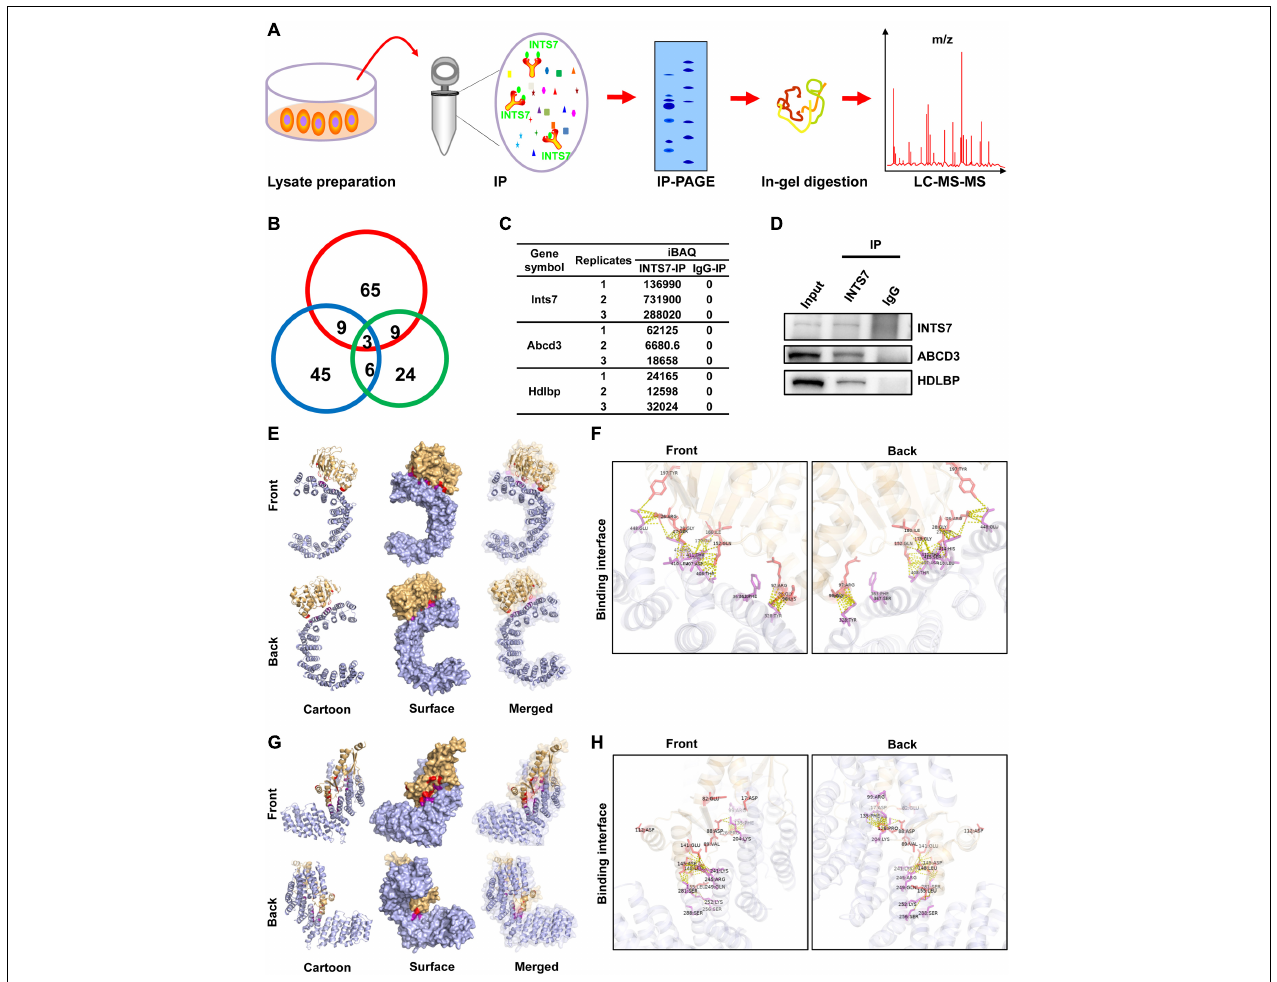
FIGURE 3 | INTS7 interacts with ABCD3 and HDLBP in BM-MSCs. (A) The procedures used to identify INTS7-interacting proteins in BM-MSCs: total endogenous proteins were collected, subjected to INTS7 antibody-based immunoprecipitation, IP-PAGE, in-gel digestion, liquid chromatography separation, and mass spectrometry analysis. (B) Three replicates in (A) were performed, and the quantities of co-occurring proteins were evaluated. (C) The protein expression levels were estimated by the iBAQ algorithm embedded in MaxQuant. (D) Protein extracts were incubated with an anti-INTS7 antibody for IP assays, followed by western blot analysis with anti- INTS7, anti-ABCD3, or anti-HDLBP antibodies. (E) Visualization of the docking interface between INST7 and ABCD3. The front and back views of the docked protein complex between ABCD3 (orange) and INTS7 (blue). The cartoon mode represents the backbone and the secondary structures of the corresponding proteins. The surface mode displays the solvent-accessible surface area. The merged mode combines the cartoon and the transparent surface views. (F) The interface view shows the binding residues (in stick mode) at the interface between ABCD3 and INTS7. The interacting residues are colored in red and purple for ABCD3 and INTS7, respectively. The molecular contacts between interacting residues are indicated by dashed yellow lines. (G) Visualization of the docking interface between INTS7 and HDLBP. The front and back views of the docked protein complex between HDLBP (orange) and INTS7 (blue). (H) The interface view shows the binding residues (in stick mode) at the interface between HDLBP and INTS7. The interacting residues are colored in red and purple for HDLBP and INTS7, respectively. The molecular contacts between the interacting residues are demonstrated by dashed yellow